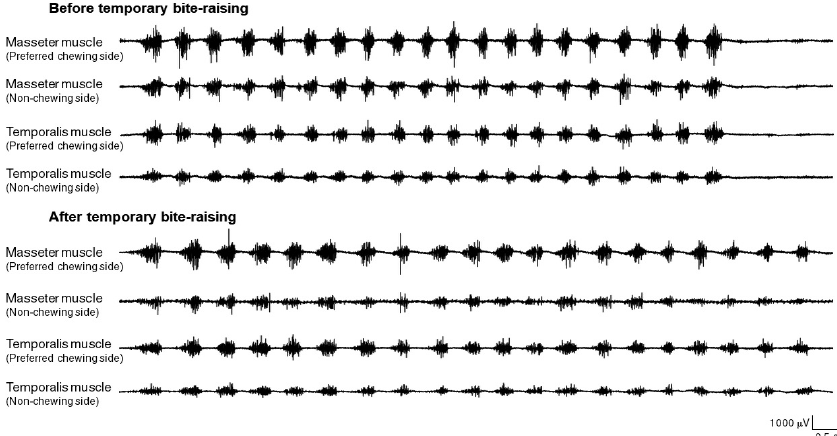
Figure 2- Representative masseter and temporalis muscle electromiography (EMGs)during mastication (test C) before and after temporary